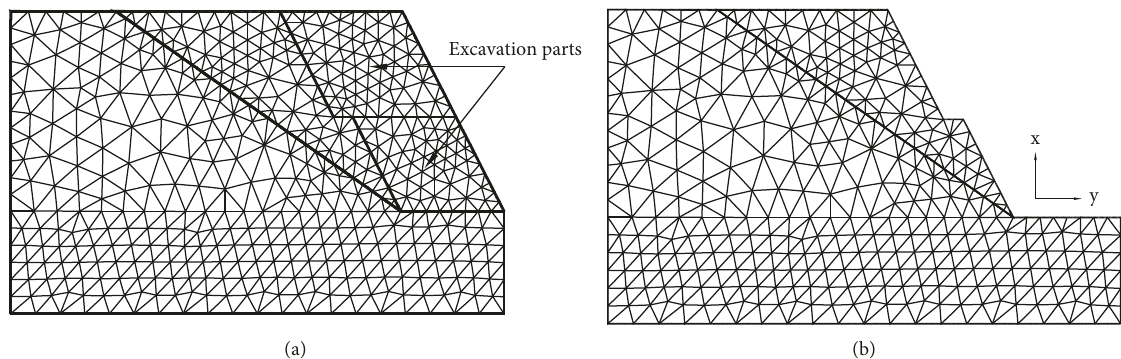
Figure 4: FE mesh models of the slope before (a) and after (b) excavation. Model (a) is used for the study in Section 4.6, and the other sections select Model